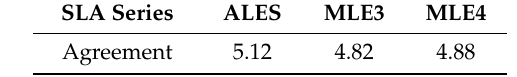
Table 7. Secular trend and associated uncertainty (mm/yr) for case 1, with different geophysical corrections choices. DAC = dynamic atmospheric correction.